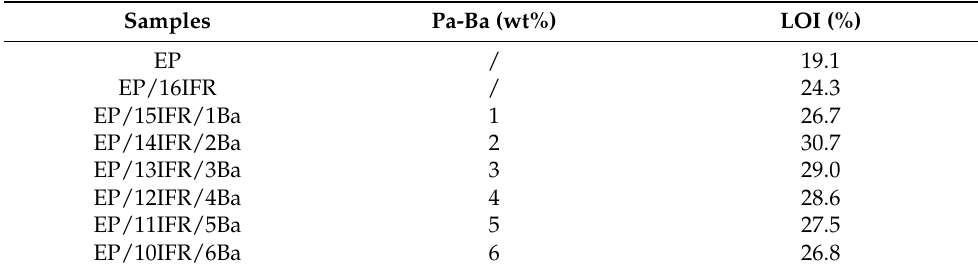
Table 3. LOI values of pure EP and EP